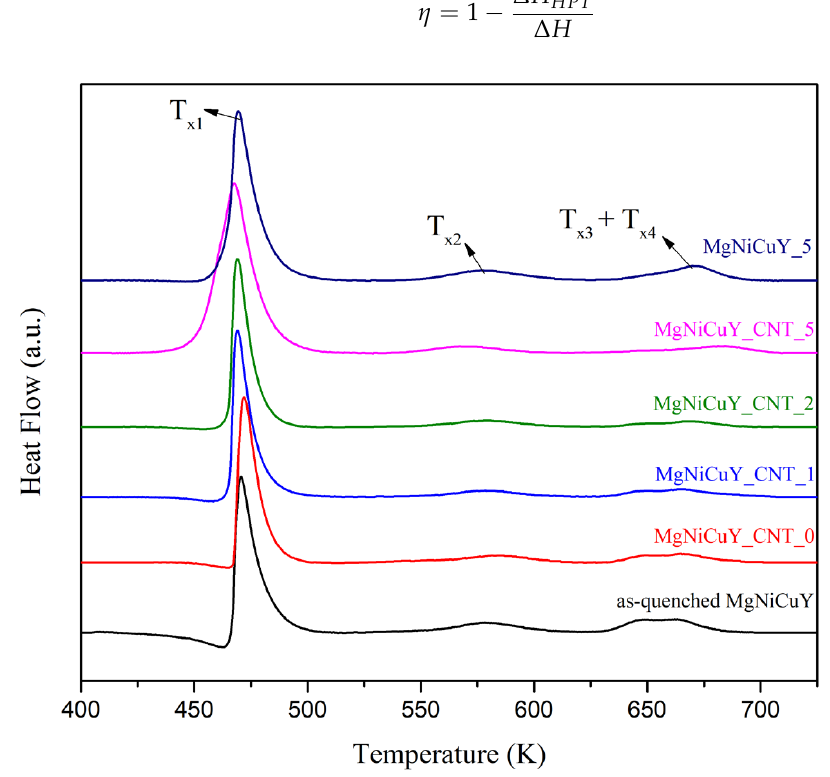
Figure 4. XRD patterns recorded on Mg 65 Ni 20 Cu 5 Y 10 HPT disks and the as-quenched ribbon.